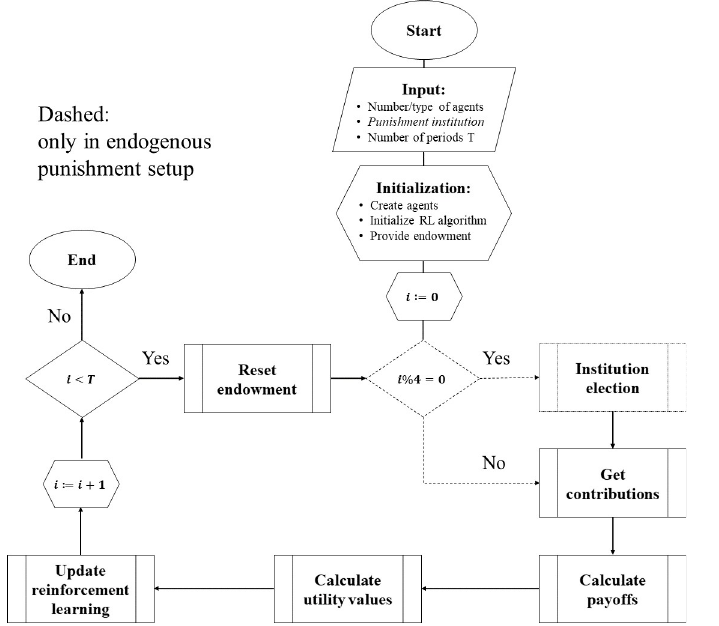
Fig 1. Flow chart of essential modules in our simulation model.